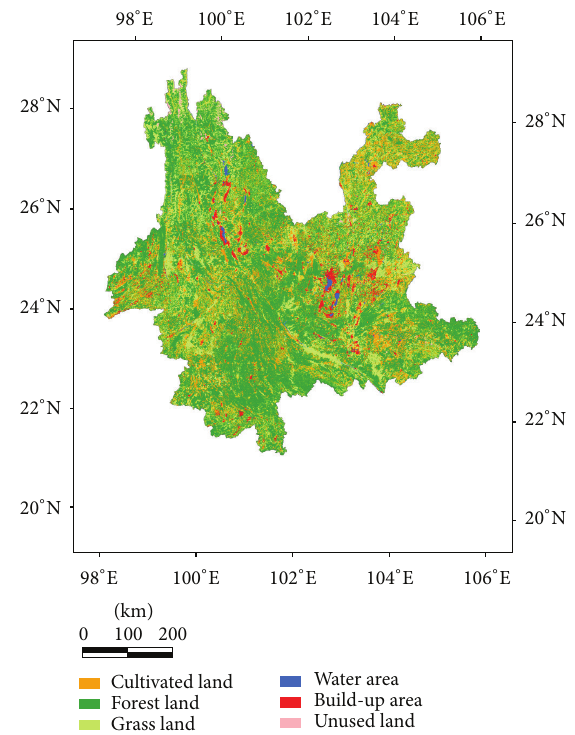
Figure 1: Land use pattern of Yunnan province in year